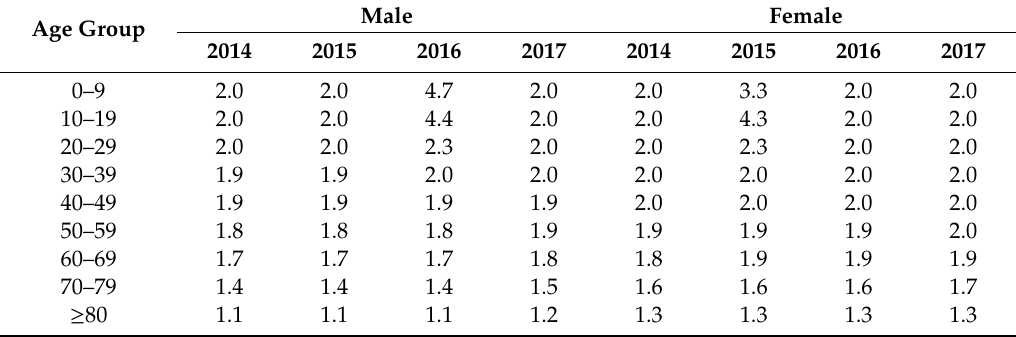
Table A2. Duration of tuberculosis in Korea in years by sex and age, 2014–2017.